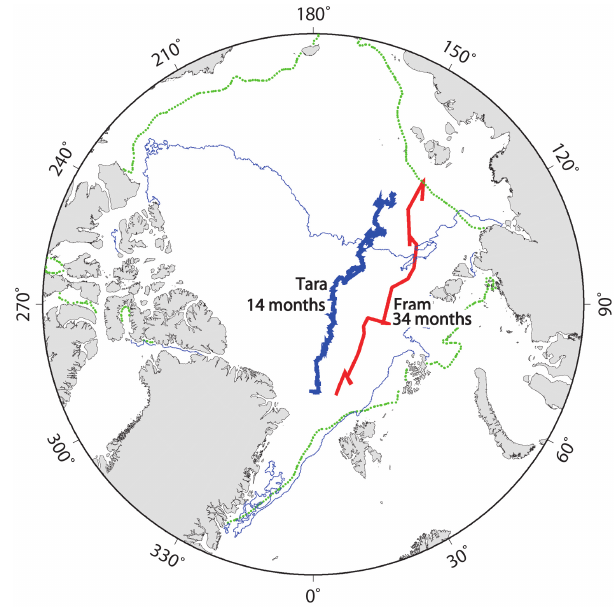
Figure 2. Drift trajectories of the vessels Tara (blue, November 2006–January 2008) and Fram (red, October 1893–August 1896). The sea ice edges are displayed for September 2007 (blue) and for the September mean 1979–1983